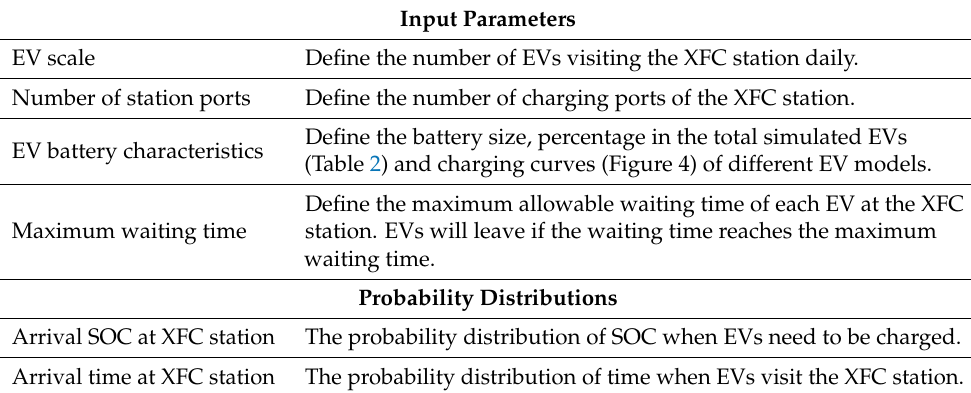
Table 1. Parameters of EV Charging Demand Estimation.